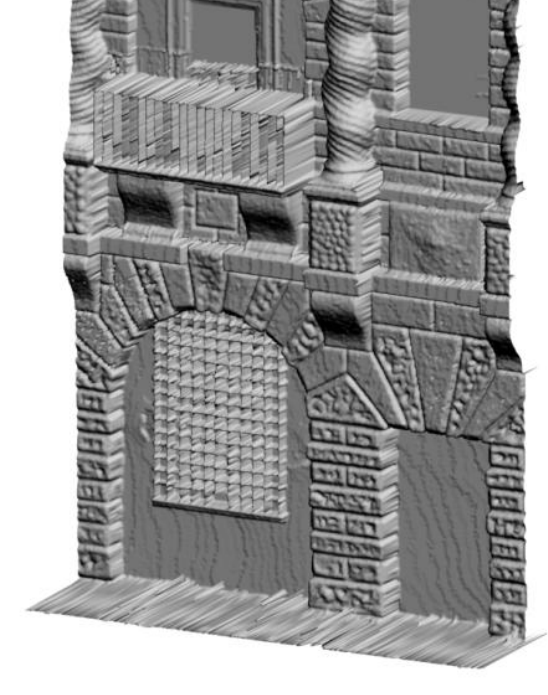
Figure 3. 3D model made by displacement map